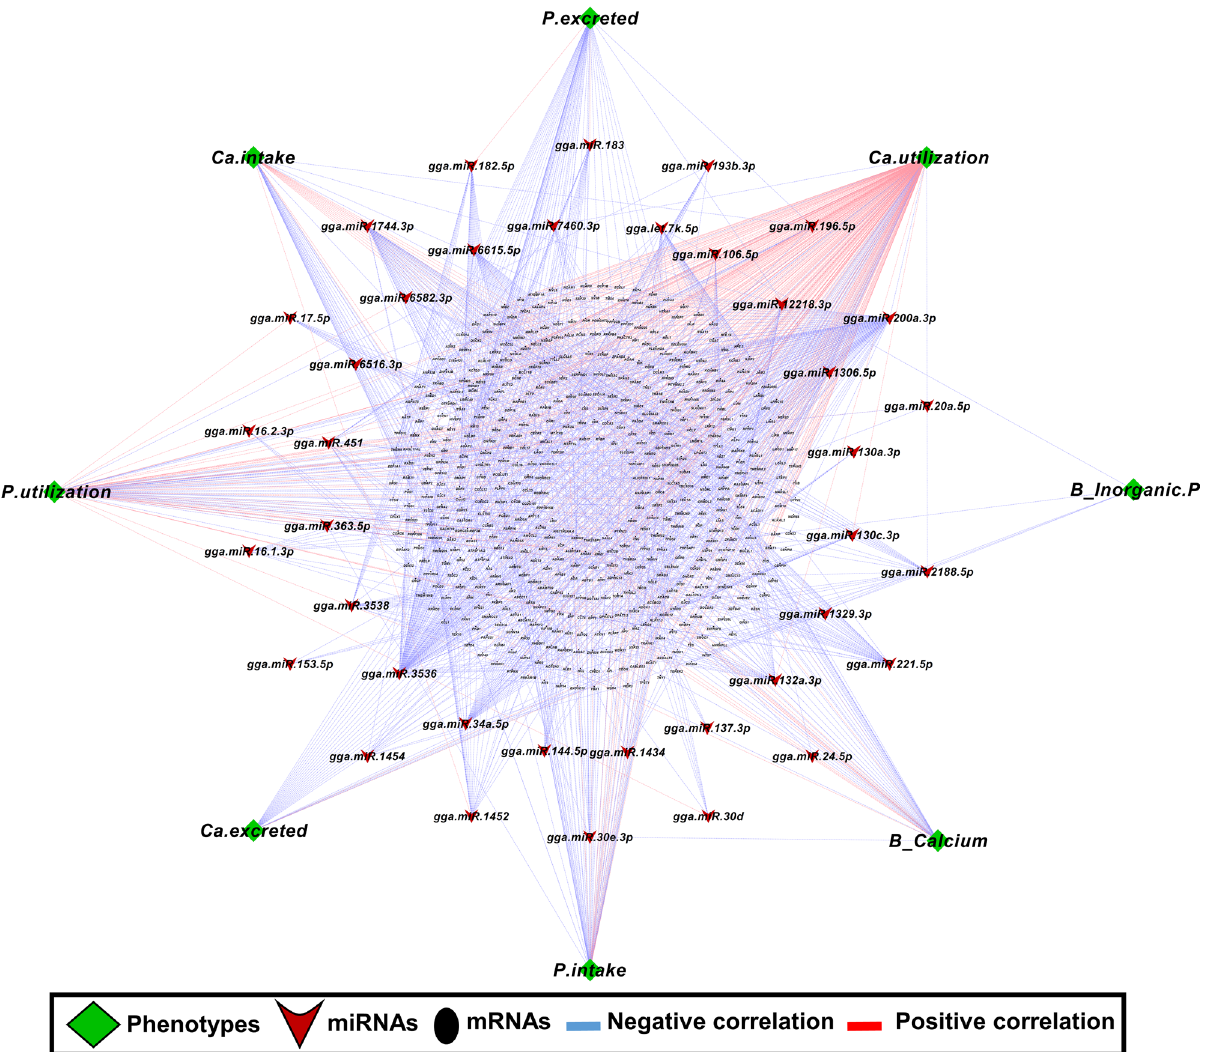
Figure 11. Correlation network analysis of known miRNAs-mRNA and phenotype from different diet groups within LB strain. Correlation network was generated using MetScape (version 3.1.3) plugin in Cytoscape (version 3.6.1) environment. The mRNAs with negative correlation with miRNAs were considered significant. Green color diamond shape indicates phenotype data within LB strain. Red V-shape indicates the deferentially expressed known miRNAs from different diet groups within in LB strain and black ellipse shape indicates mRNA. Blue line indicates the correlation between Phenotype-miRNA and